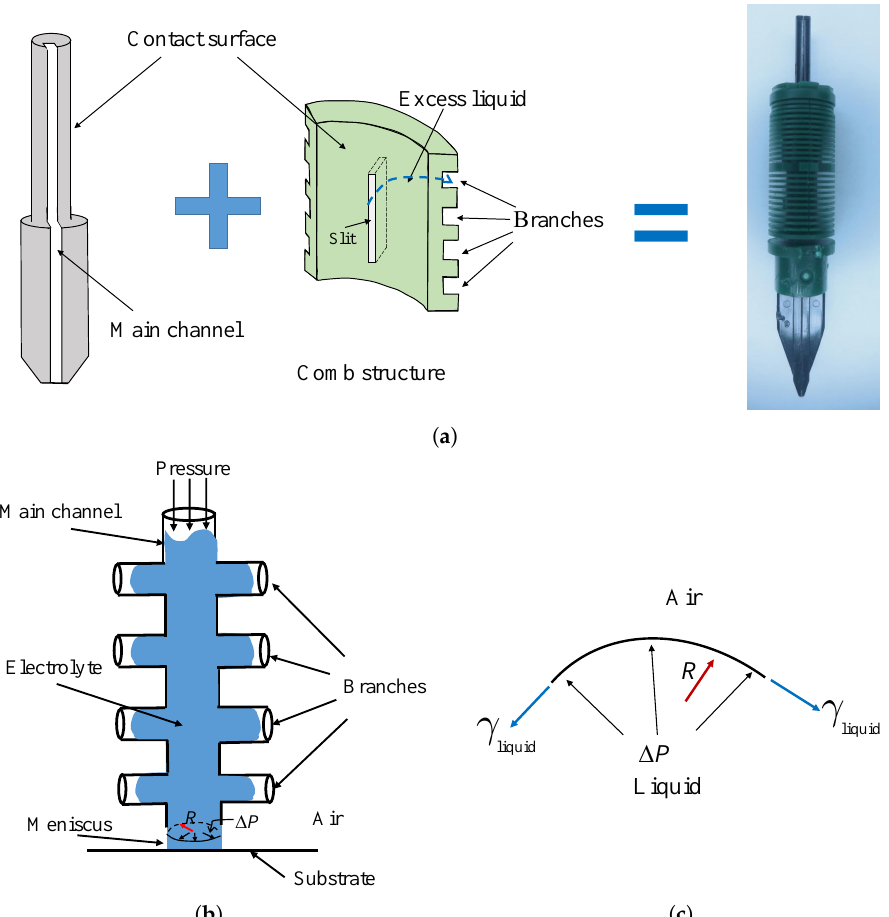
Figure 2. ( a ) The detailed illustration of the main channel and the comb structure. Excess fluid can flow through the slit of the comb structure and to the outside branches. ( b ) Schematic illustration that how the branches can help to main a stable meniscus. ( c ) Force diagram of the meniscus at the interface between liquid and